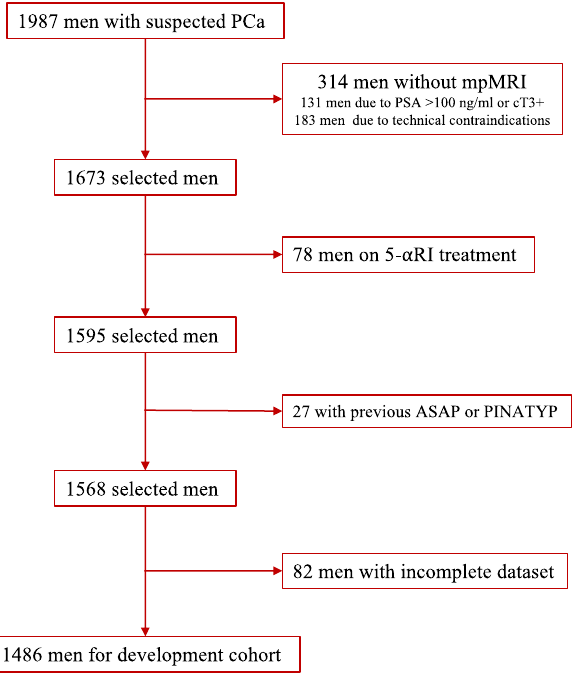
Figure 1. Flow chart of development cohort creation: inclusion and exclusion criteria.